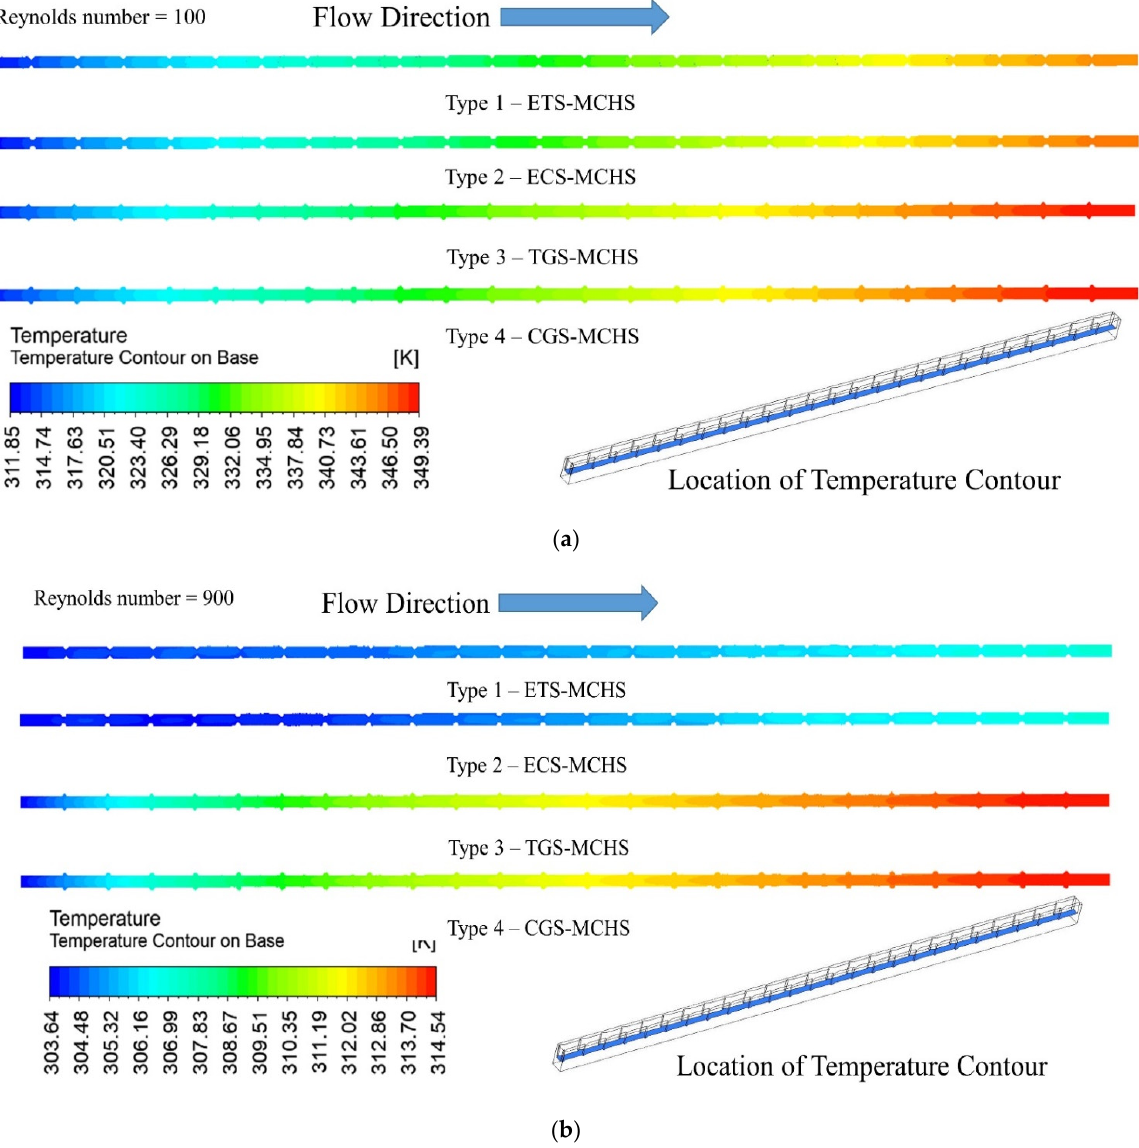
Figure 8. Temperature contour of MCHS (at base of passage) for ( a ) Re = 100 and ( b ) Re =